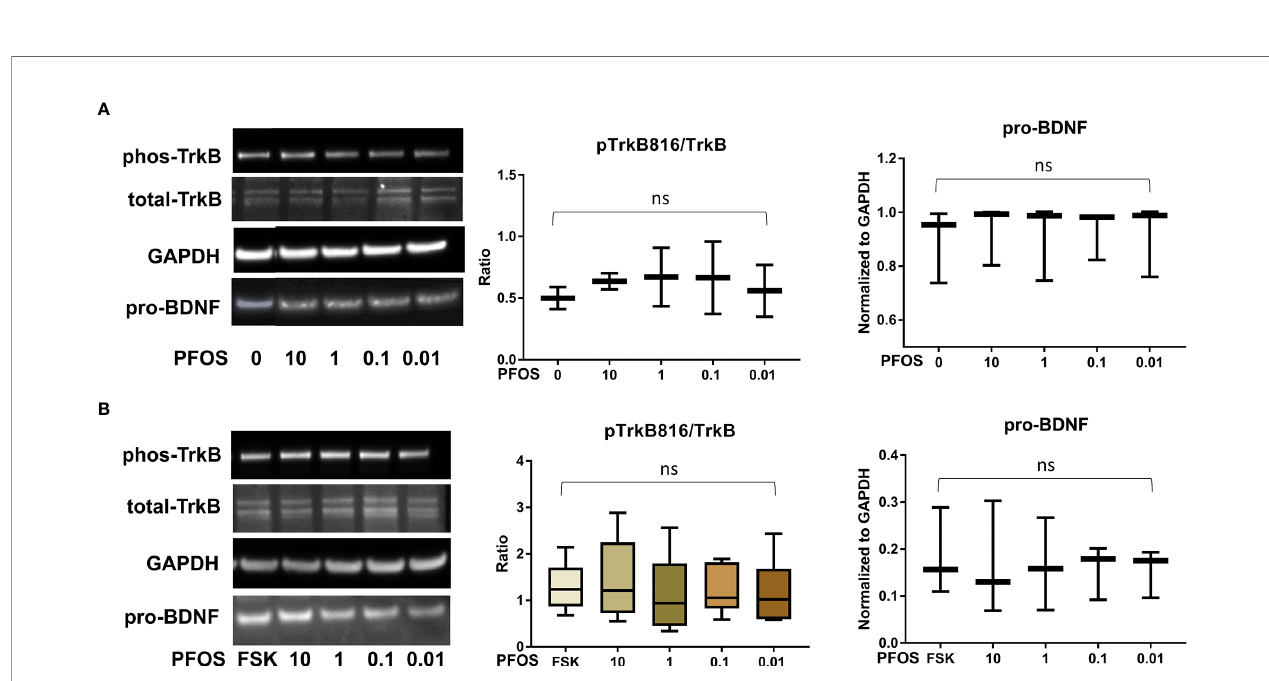
FIGURE 4 | PFOS exposure did not signi fi cantly disrupt the BDNF-TrkB pathway. (A) Representative Western blot images of phos-TrkB, total-TrkB, GAPDH, and pro-BDNF in BeWo cells without forskolin (FSK) treatment exposed to PFOS (0, 0.01, 0.1, 1, and 10 µM) and box plots for densitometry analysis; (B) Representative Western blot images of phos-TrkB, total-TrkB, GAPDH, and pro-BDNF in BeWo cells with FSK treatment exposed to PFOS (0, 0.01, 0.1, 1, and 10 µM) and box plots for densitometry analysis. ns indicates differences in protein levels were not signi fi cant. pTrkB816 represents for phosphorylation of TrkB at Tyr816 residue.